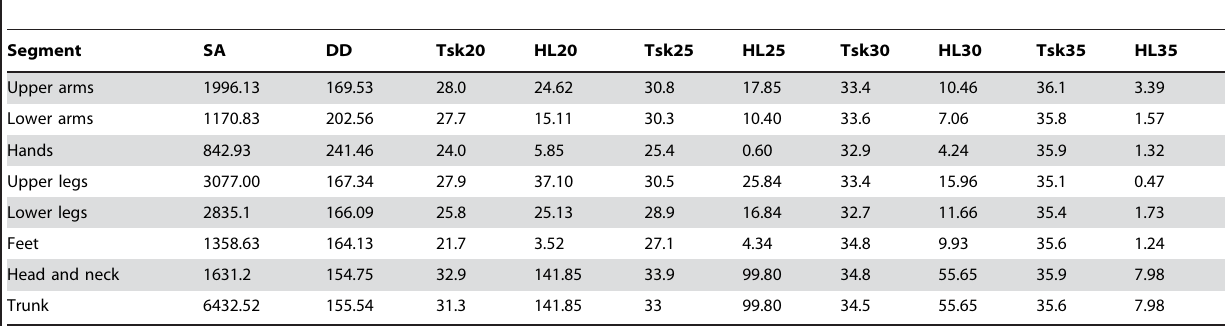
Table 5. Mean segment surface areas, displacement distances, skin temperatures and heat loss.